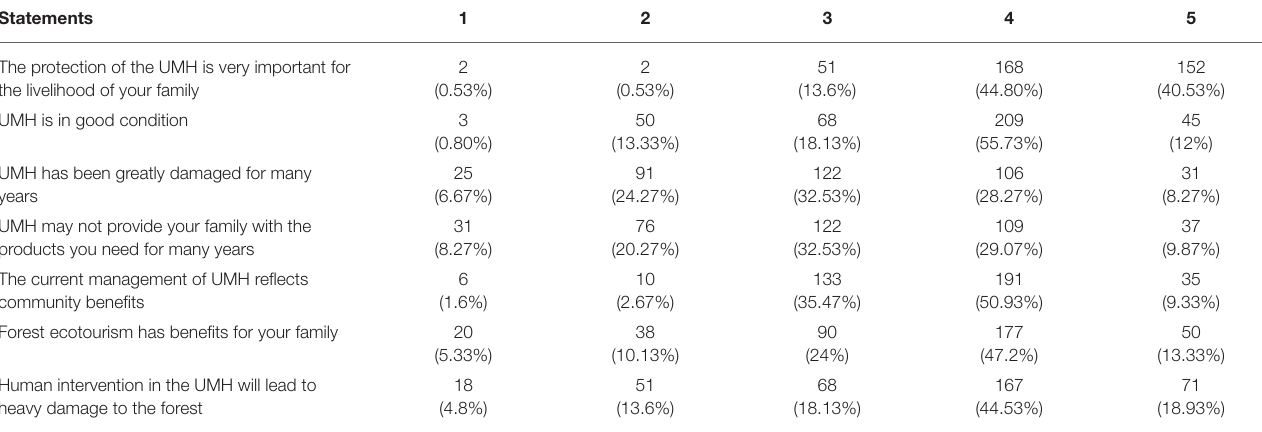
TABLE 1 | Perceptions of forest conservation and forest use.